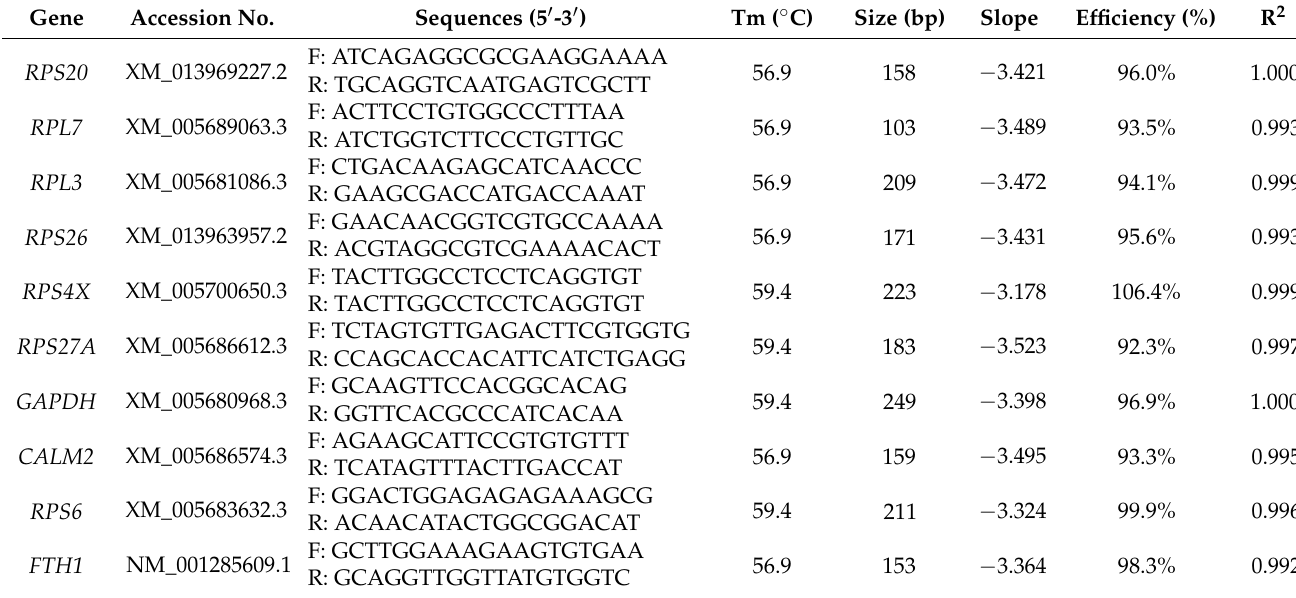
Table 1. The primer sequence information, standard curve amplification efficiency, and R 2 values used in this study. Gene Accession